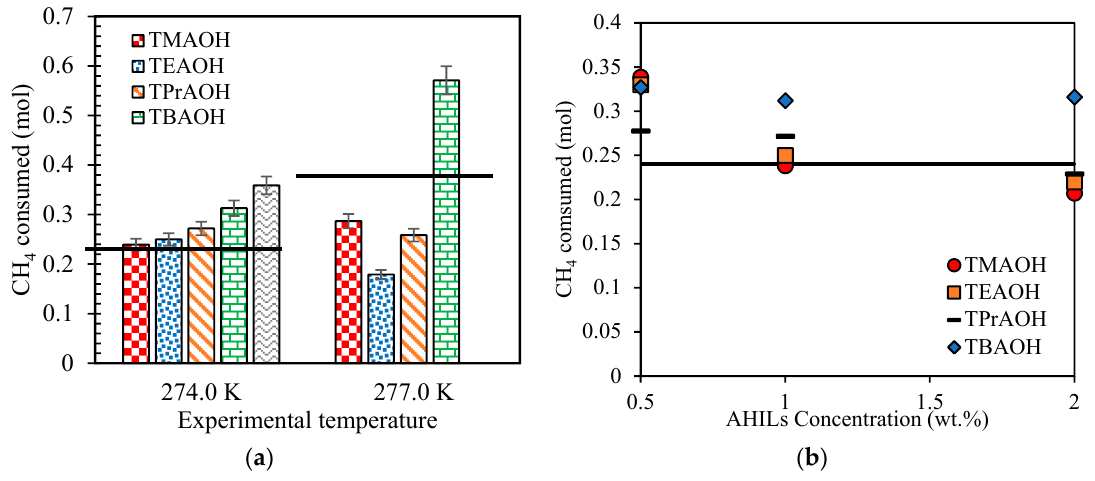
Figure 7. ( a ) Effect of AHILs on the measured CH 4 consumed moles at different experimental temperatures at 1 wt%; ( b ) Effect of AHILs concentrations on the CH 4 consumed moles at 274.15 K; The black line symbolizes pure water values; No hydrate formation was observed for PVP at 277.0 K.